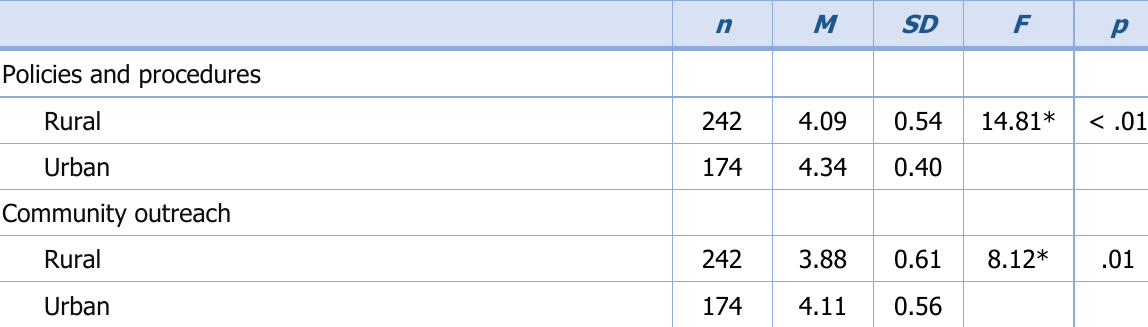
Table 9. Differences Between 4- H Extension Agents’ Perceived Importance of the AEO Domain’s Inclusive Organizations Components and the Rural/Urban